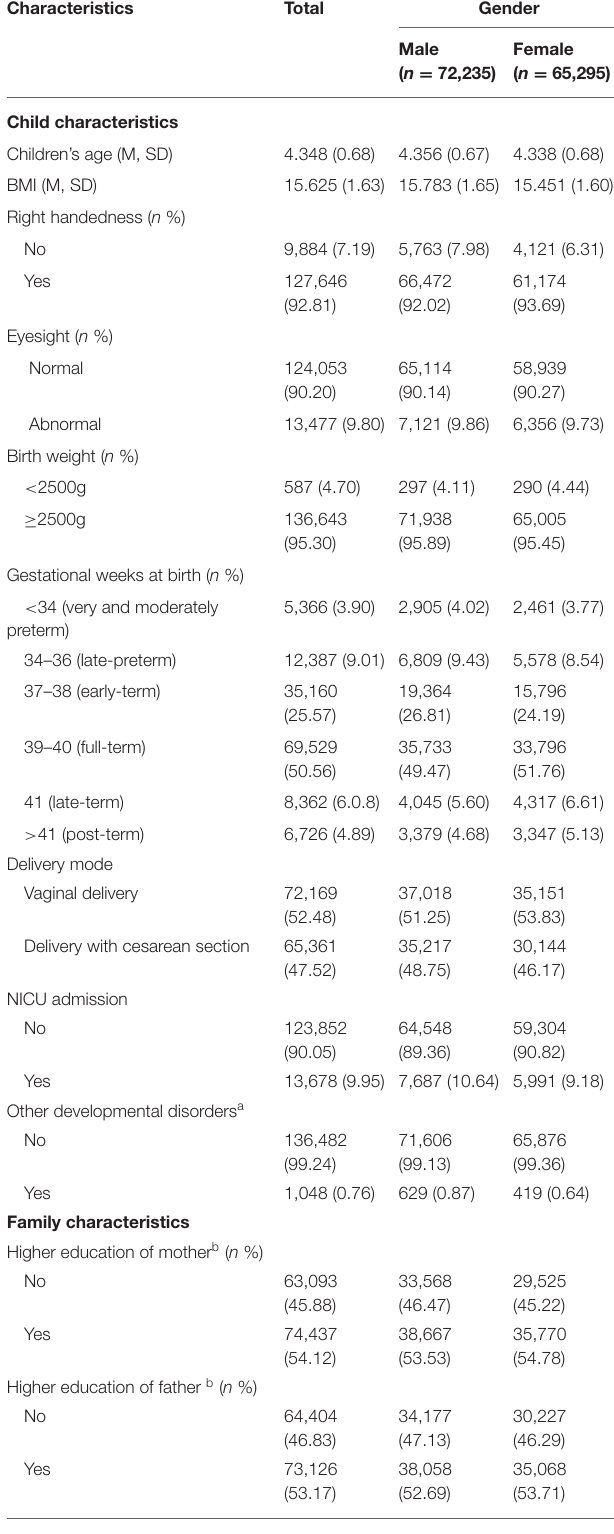
TABLE 1 | The child and family characteristics of the study population ( n = 137,530).